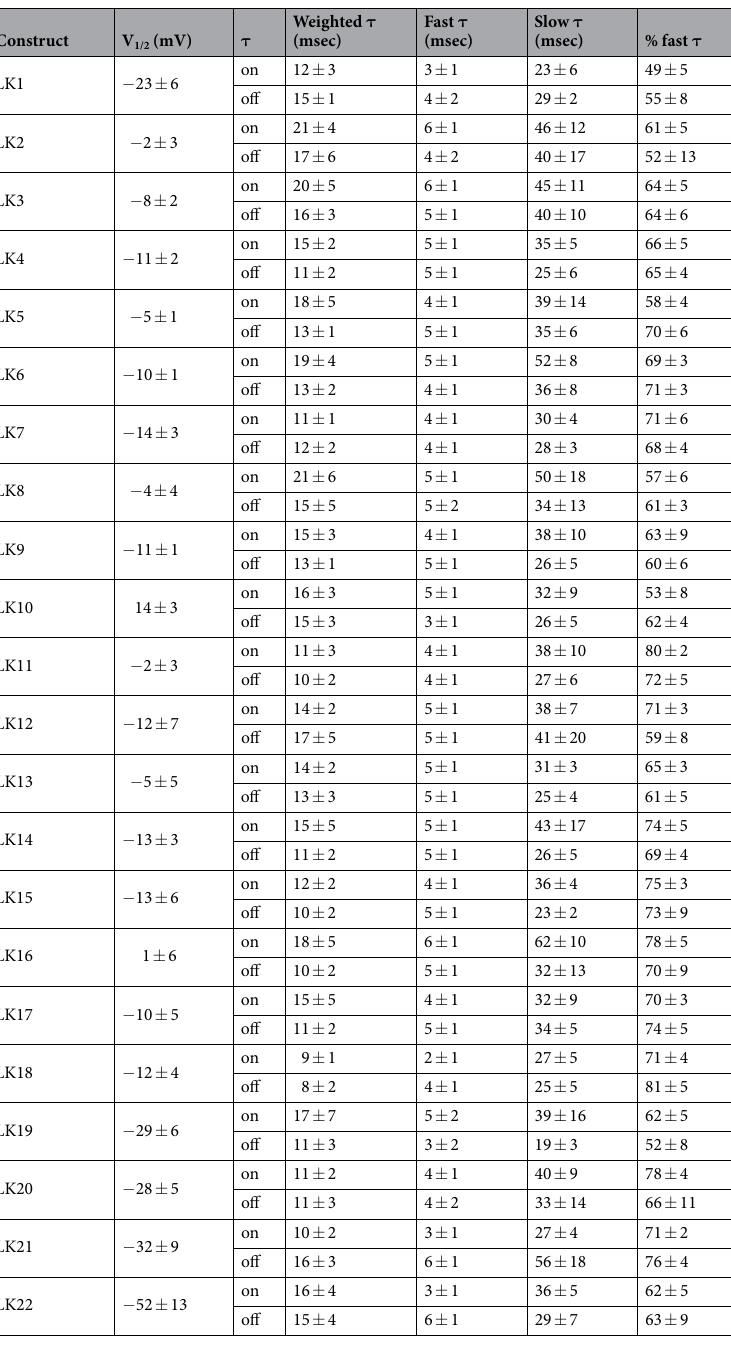
Table 1. Physical properties of the 22 linker